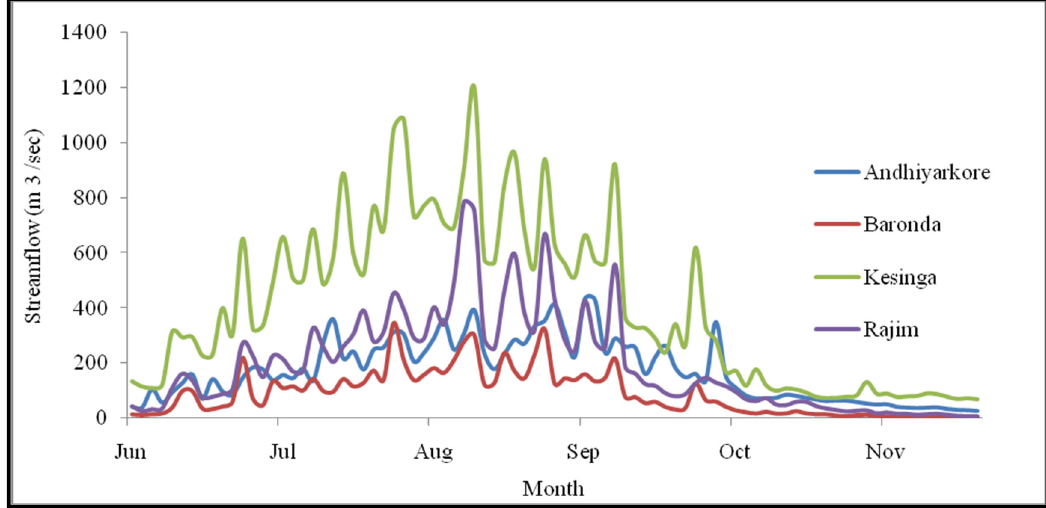
Figure 2. The daily streamflow climatology at four selected stations (1980–2013), Andhiyarkore ( blue ), Baronda ( red ), Rajim ( violet ), and Kesinga ( green ).